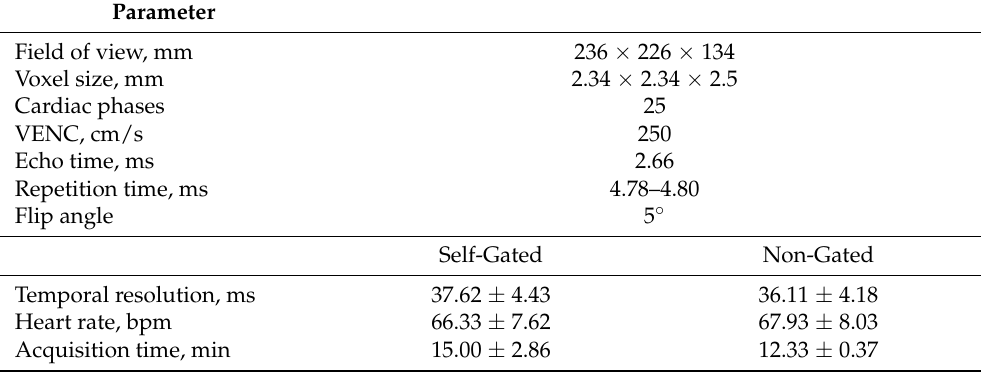
Table 1. The MRI acquisition